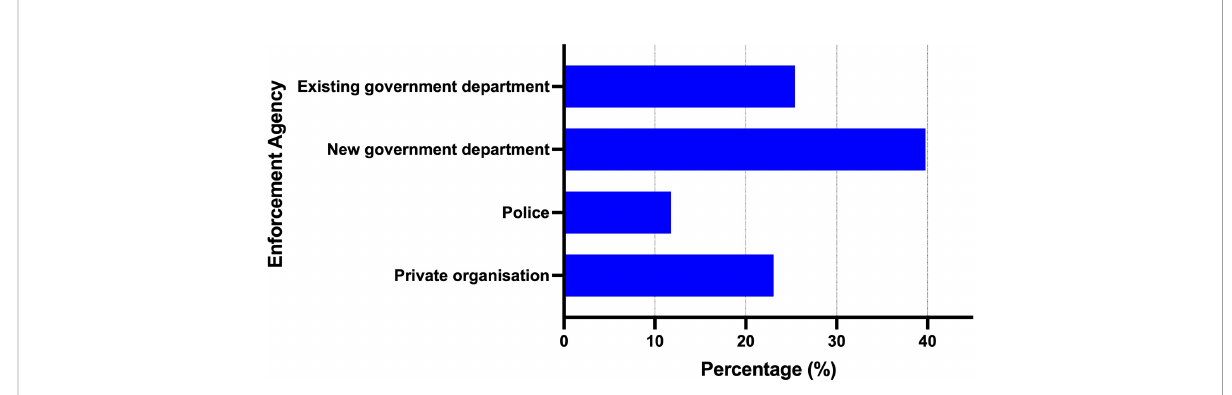
FIGURE 3 Enforcement agency preferences of respondents (n=2152). “ In your opinion, which organization should enforce animal welfare law? ”